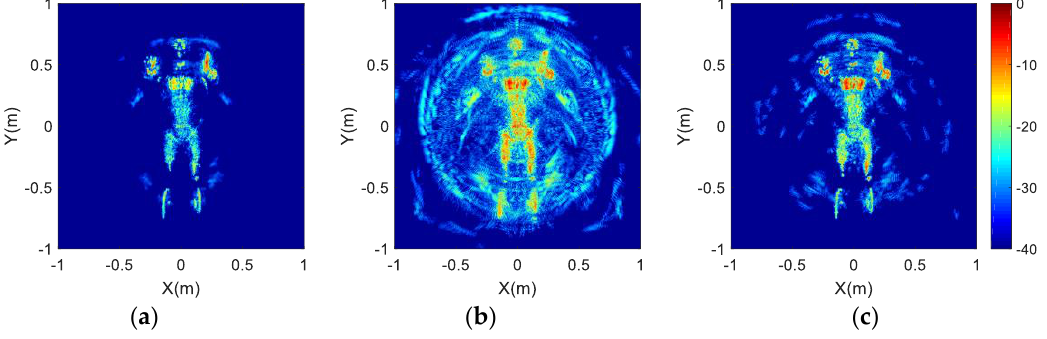
Figure 10. Imaging results of the human-scattering model: ( a ) Optimized array; ( b ) Uniform array 1; ( c ) Uniform array 2.